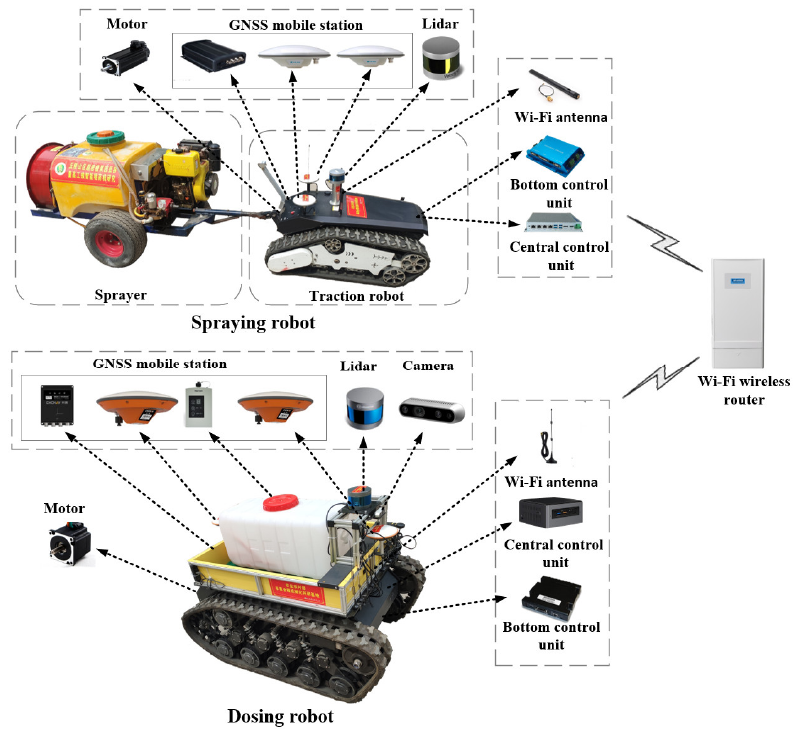
Figure 1. The hardware structure of the spraying–dosing robot cooperative navigation system. The central control unit of the spraying robot adopts UNO-2484G computer, the bottom control unit includes a KYDBL2450-2E motor controller and two 48 V DC brushless motors, the centimeter-level accuracy RTK-GNSS in the positioning unit is composed